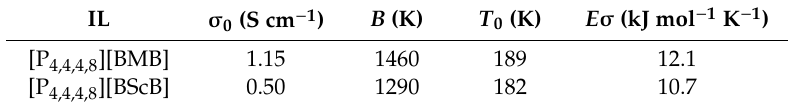
Table 1. VFT equation parameters and activation energies for the ionic conductivity data of the ILs.